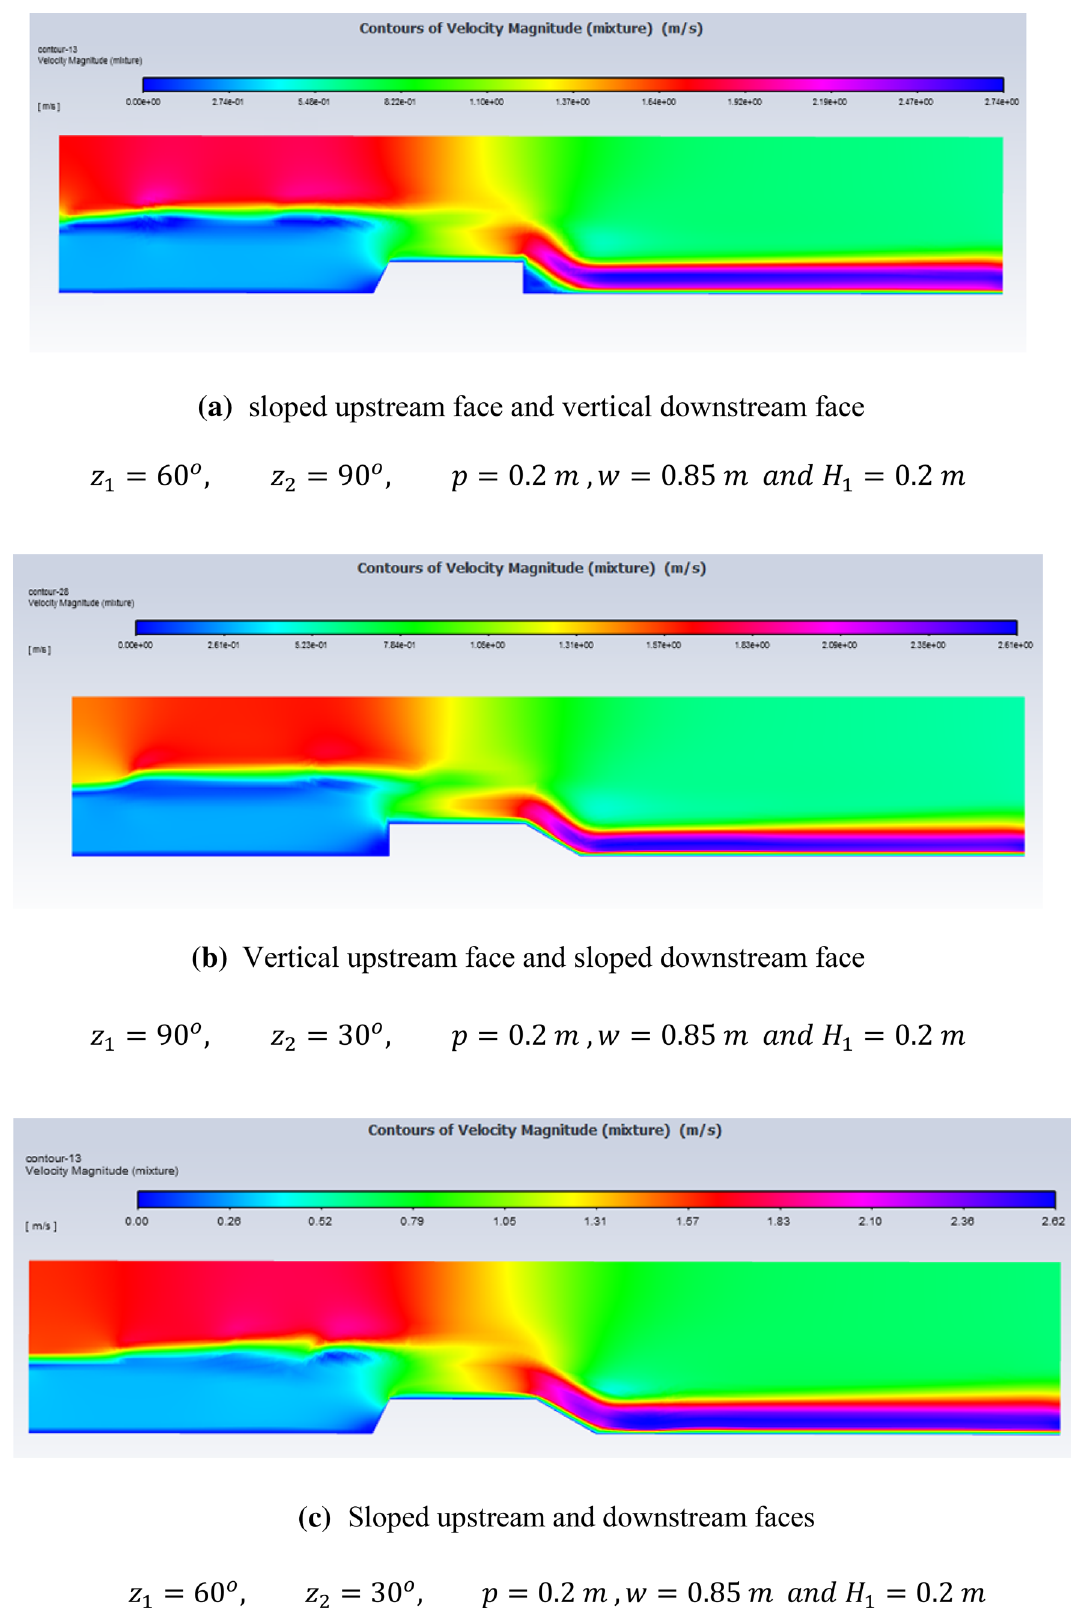
Fig. 4 a , b and c : Velocity contours on the broad-crested weir for three different face slope